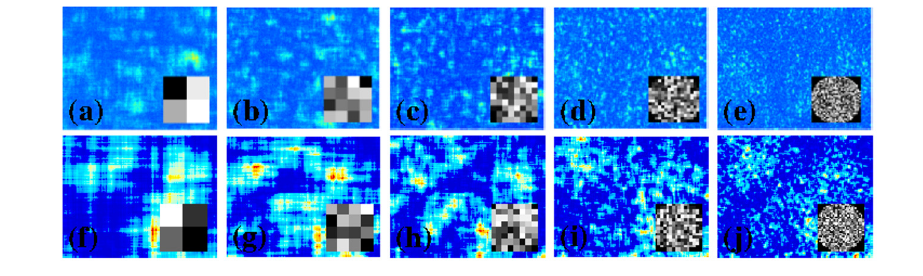
Figure 3. Speckle size as N increases. The SLM segment values are random. The images in ( a ) to ( e ) were created using the sandblasted aluminum reflector with N = 2 through N = 32, respectively. The images in ( f ) to ( j ) were simulated using a reflector model with a uniform phase distribution for N = 2 through N = 32, respectively.